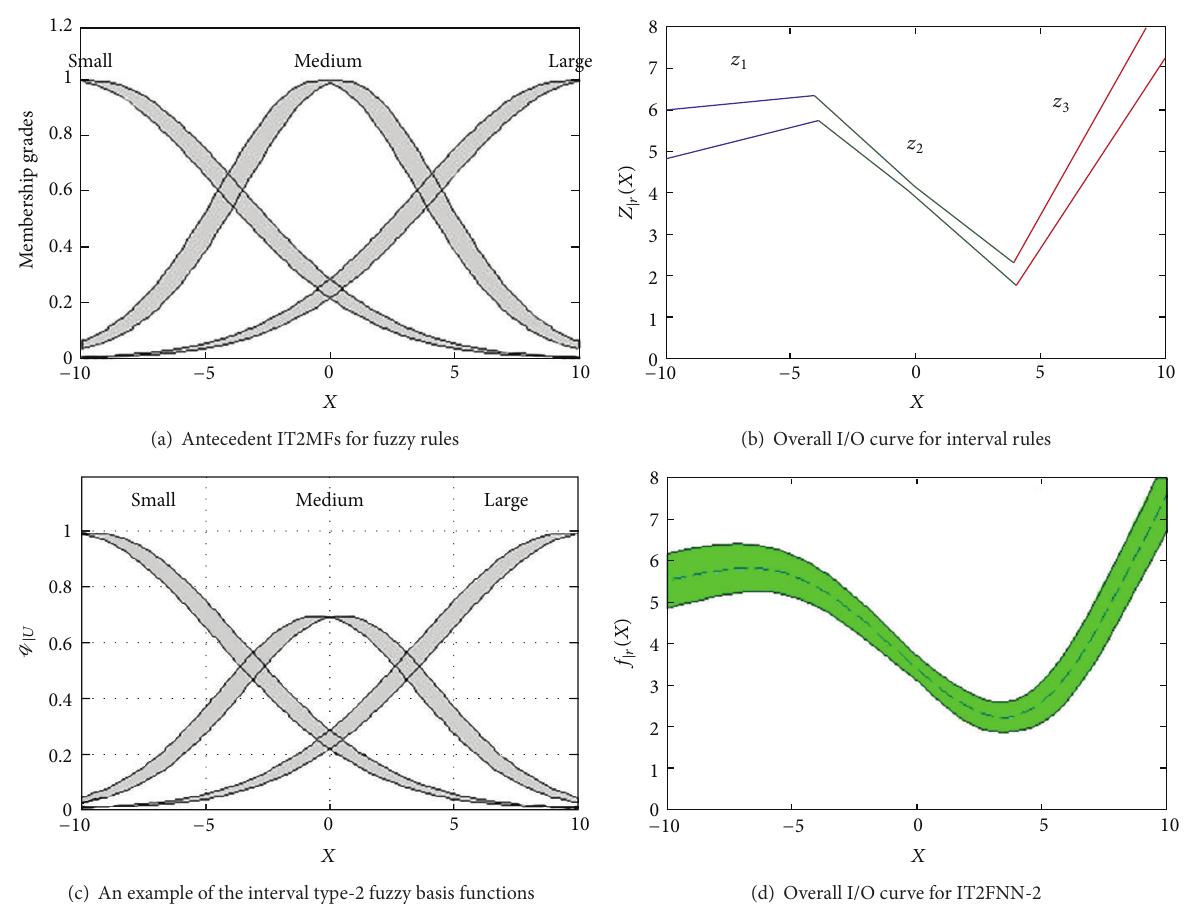
Figure 6: An example of the IT2FNN-2